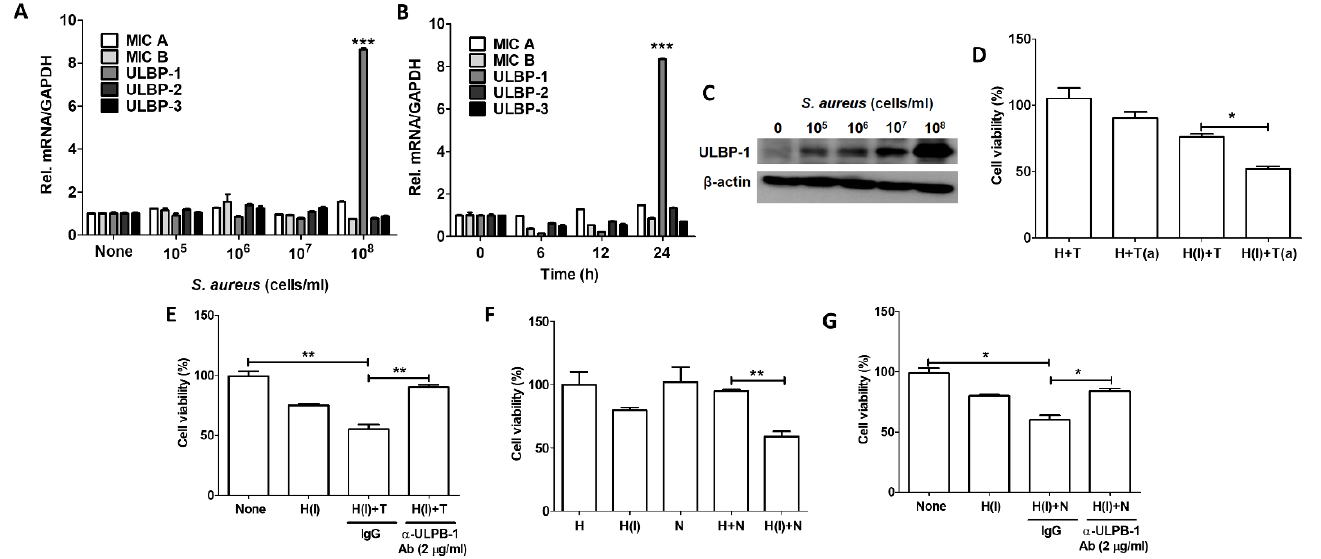
Figure 5. S. aureus -infected HaCaT cells produced increased ULBP-1. The mRNA levels of NKG2D ligands were examined by real-time PCR according to the S. aureus dose ( A ) and treatment time ( B ). The data displayed are the mean ± SD of three independent experiments. Statistical analysis was conducted with a one-way ANOVA. *** p < 0.001 vs. 0 h or None. ( C ) The ULBP-1 protein level was examined via Western blotting. ( D ) A cell viability test was performed after coculturing HaCaT cells and THP-1 cells. ( E ) A cell viability test was performed after coculturing HaCaT cells pretreated with a neutralization antibody and THP-1 cells. ( F ) A cell viability test was performed after coculturing HaCaT cells and NK cells. ( G ) A cell viability test was performed after coculturing HaCaT cells pretreated with neutralization antibody and NK cells. (a) Indicates activated THP-1 cells; (I) indicates cells infected by S. aureus . The data displayed are the mean ± SD of two independent experiments. Statistical analysis was conducted with an unpaired two-tailed t test. * p < 0.05, ** p < 0.01.